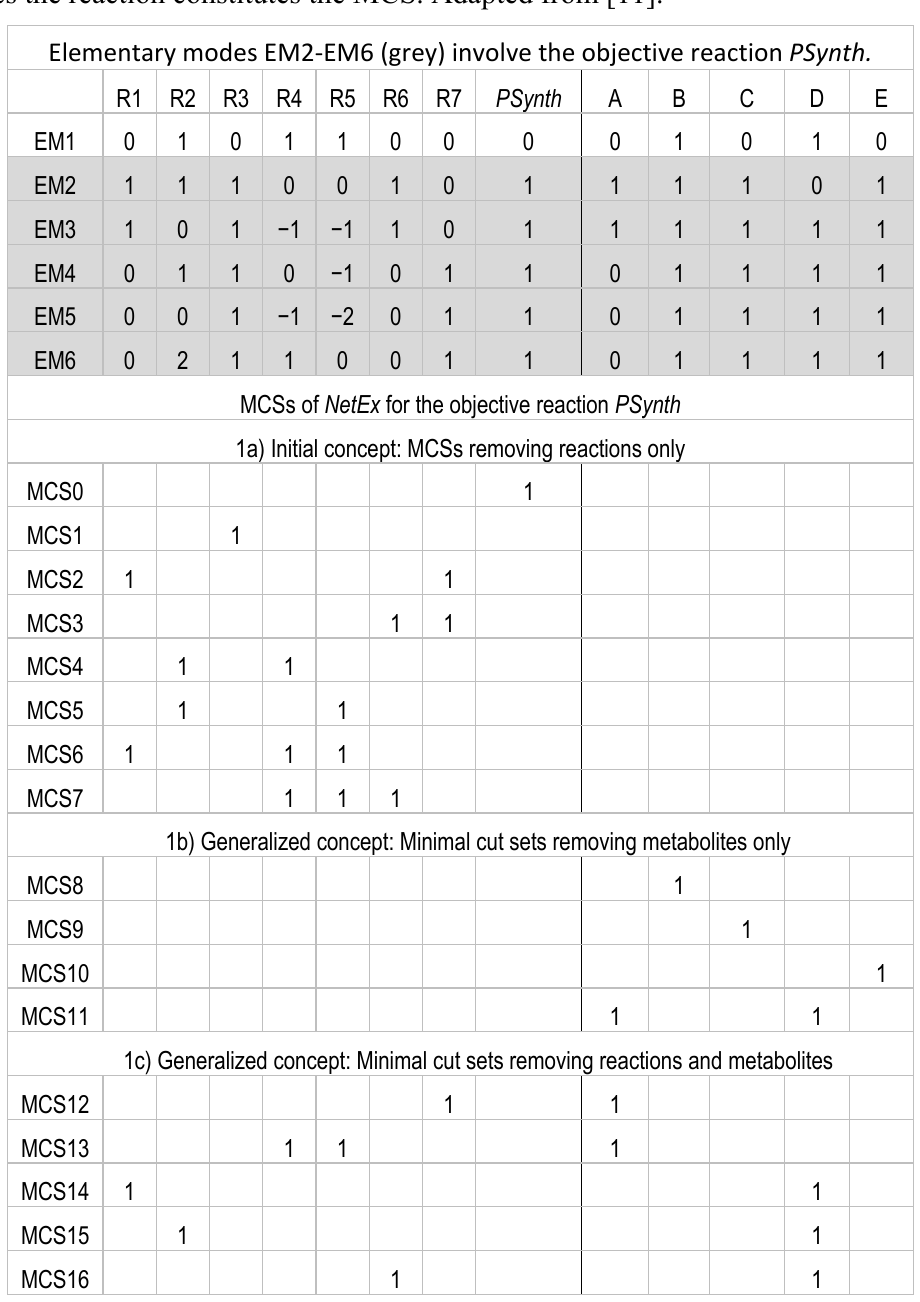
Table 1. Elementary modes and the different types of MCSs of NetEx for the objective reaction PSynth. Initial MCS concept: 1a): removing reactions only; Generalized MCS concept: 1b) removing metabolites only, and 1c) reactions and metabolites together. Note: a non-zero in the EM cell indicates the reaction occurs in the EM; a “1” in the MCS indicates the reaction constitutes the MCS. Adapted from